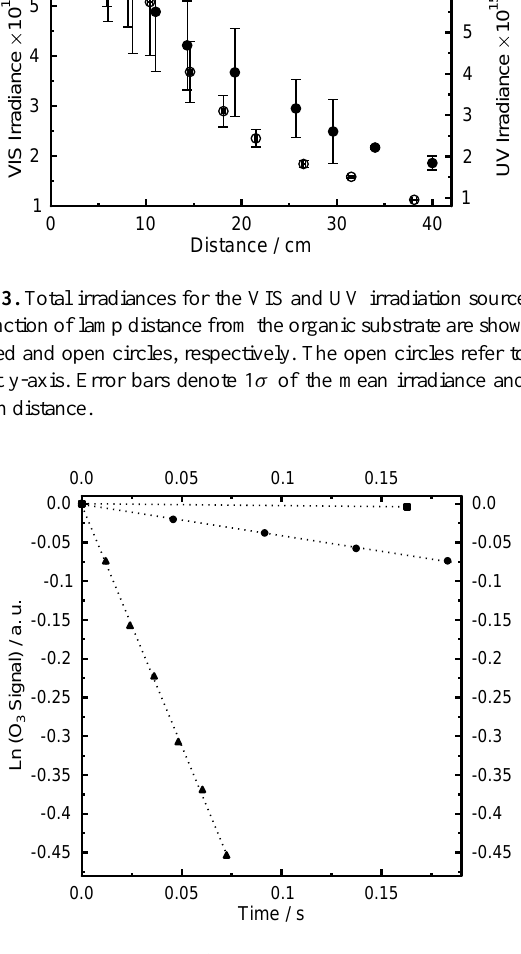
Fig. 4. Natural logarithm of the normalised ozone signal as a func- tion of reaction time. Squares, circles, and triangles denote exem- plary reactive uptake data of O 3 by a blank glass block, the 1:1 by mass PP/NG substrate, and canola oil, respectively. Dotted lines represent linear fits of the data from which the observed first-order rate constants are